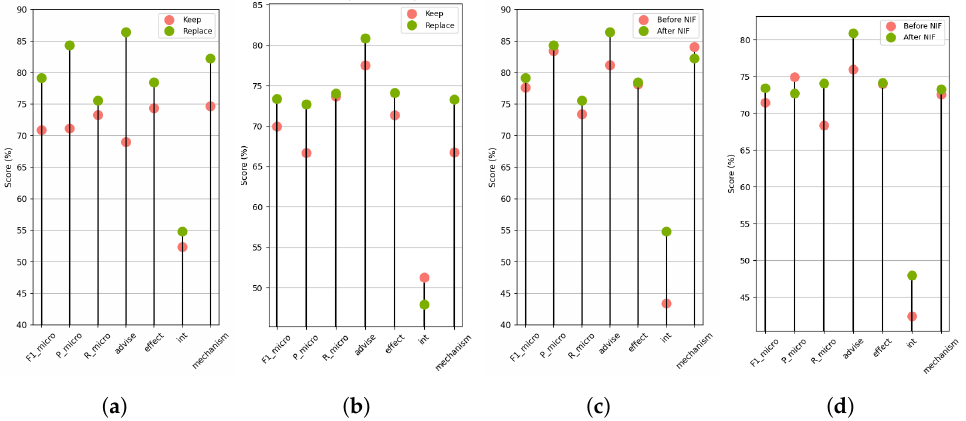
Figure 5. Performance comparison based on Drug Name Replacement (DNR) and Negative Instance Filtering (NIF), ( a ) M3.3 with DNR, ( b ) M8.2 with DNR, ( c ) M3.3 with NIF, ( d ) M8.2 with NIF.